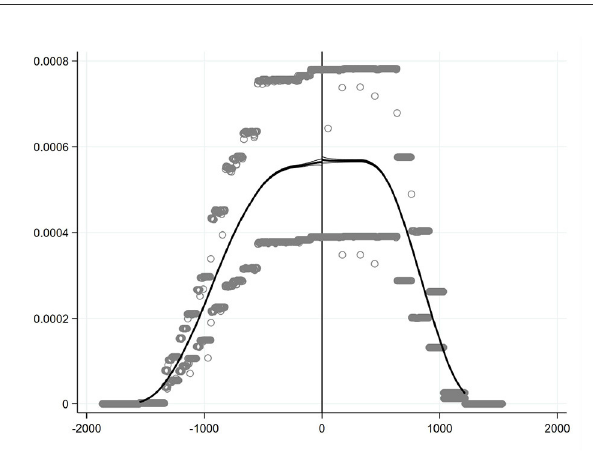
TABLE 2 Descriptive statistics of variables.